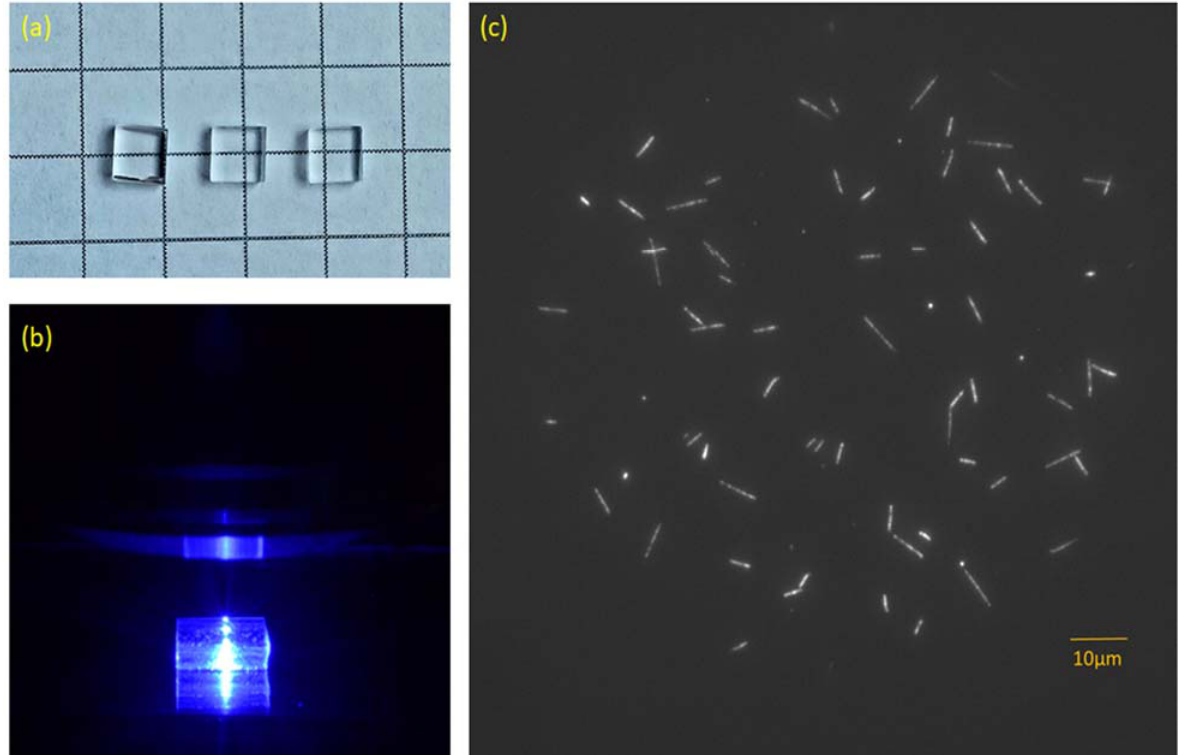
Figure 1. ( a ) LiF crystal samples after being cut and polished; ( b ) magnified image of a LiF sample illuminated with blue light (440 nm) during read ‐ out with Nikon Eclipse wide ‐ field microscope; ( c ) examples of fluorescent tracks registered at RT after irradiation with alpha particles from Am ‐ 241 source (particle fluence around 10 6 cm − 2 ). The images present maximum intensity projection from 15 images acquired with focus set at different depths of the crystal in 1 μ m steps.